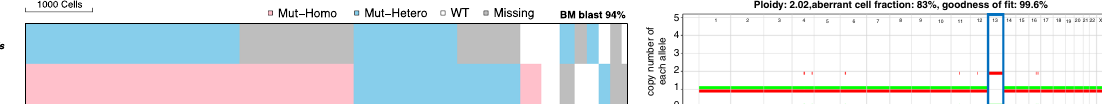
r s = 0.84 ( p < 0.001)